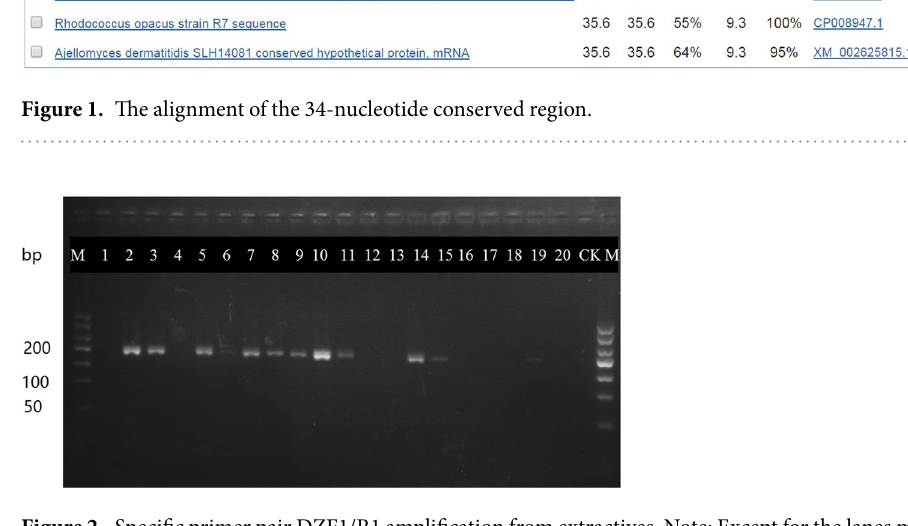
including Lingyangganmao soft capsules (ZCY03), Yinhuang soft capsules (ZCY04), Liyanjiedu particle (ZCY15), Jinsangkaiyin pills (ZCY22) and Xiaoerresuqing particles (ZCY34) (Table 2). Development and Validation of Double Peaks Quantification Method Based on SNP Sites. Two Single-nucleotide polymorphisms (SNPs) were identified for use in the double peak analysis Lonicera spp. used in NHPs. We evaluated 52 samples of Lonicera , L. macranthoides, L. macrantha, L. confuse and L. hypoglauca from all over China in which we amplified the ITS2 sequence using the universal primer pair 2 F/3R. The success rate of PCR amplification was 100%, and the size of ITS2 sequence was 420 bp. Sequence analysis of samples revealed 2 SNPs (16 bp and 64 bp) among the samples of Lonicerae japonicae Flos and Lonicera Flos. The SNP sites G and C specifically occurred in Lonicerae japonicae Flos, while A and T were present at the SNP positions in the four original species of Lonicerae Flos (Fig. 3). The specificity of the two SNPs was consistent among all the sequences obtained from Lonicerae materials. Experimental mixtures of Lonicerae japonicae Flos and four different Lonicerae Flos were used to validate the quantitative estimates from the SNP double peak method. Powdered Lonicerae japonicae Flos - Lonicerae Flos were mixed in ratios (15:1, 4:1, 1:4, 1:15) that emulate adulteration. The trace data from PCR products of mixed powders with Lonicerae japonicae Flos-Lonicerae Flos ratios indicates that the relative amounts of substituted species can be detected by height of the two peaks at SNP positions (Fig. 4). In the impurity samples, Lonicerae Flos contamination rates can be detected from Lonicerae japonicae Flos as low as 6.2% (15:1) through the trace data (Fig. 4A). Double peaks could be clearly examined at SNP positions and the height of the peaks could indi- cate the ratio roughly, e.g. at the ratio of 15:1, the main peaks G/C attributed to Lonicerae japonicae Flos were